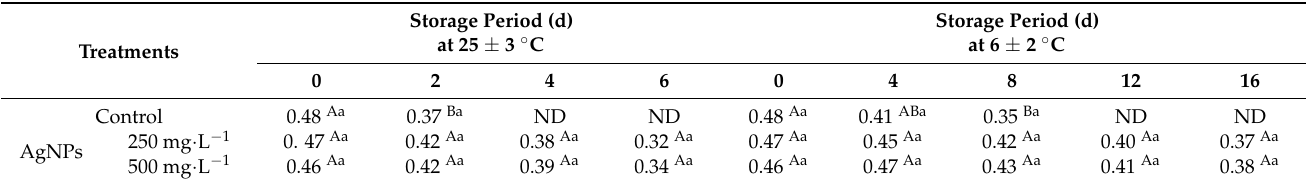
Table 5. Changes in total acidity of strawberries during storage.